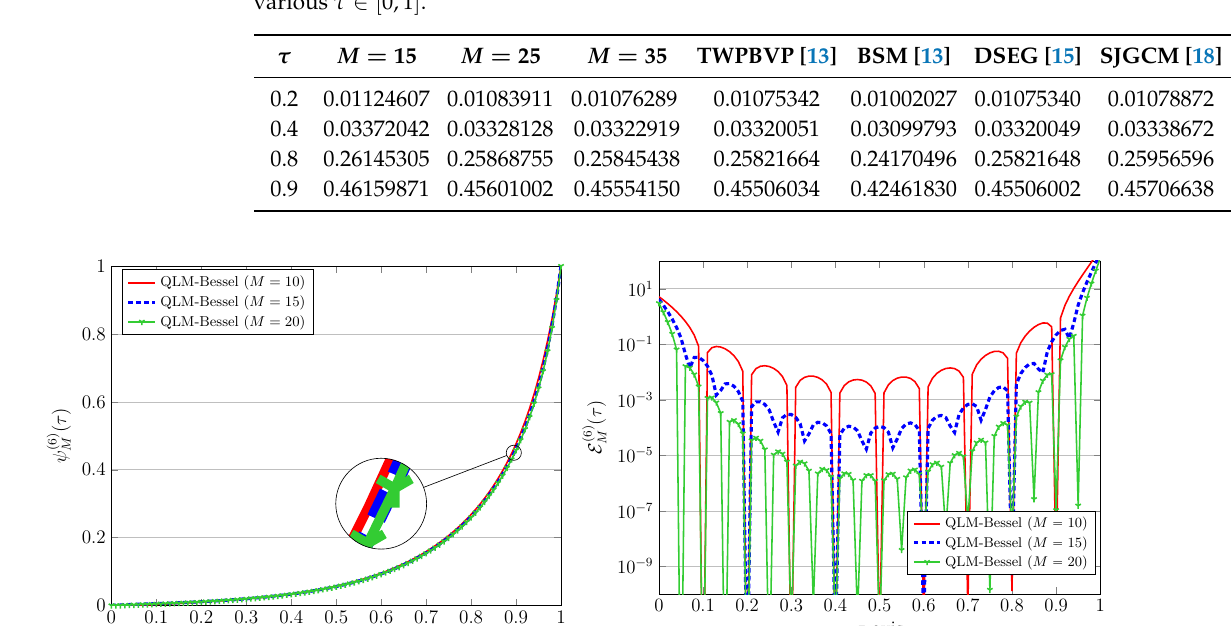
Figure 6. Comparison of numerical solutions in QLM-Bessel ( left ) and the related residual error functions ( right ) for M = 10,15,20, and r = 5 in Test case 3.